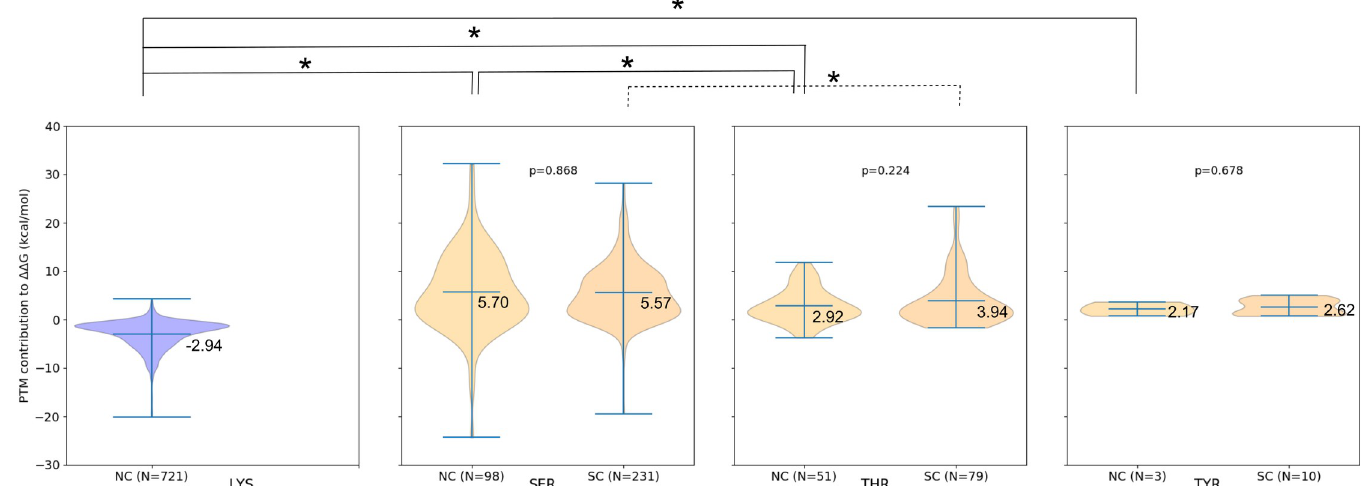
Fig 2. Comparison of local binding contributions between conditions and PTM types for the interface-located PTMs. ΔΔ G bind,contribution values in two conditions for each type of PTM (acetylation in blue, phosphorylation in orange), where NC stands for “normal conditions” and SC for “stress conditions”. Acetylation more frequently contributes to binding in a stabilizing way, as reflected in the majority of the violin plot being below zero, while the opposite is true for phosphorylation. No significant differences were found between ΔΔ G bind,contribution for PTMs of the same type between normal and stress conditions ( p -values indicated on the plots). Comparison of ΔΔ G bind,contribution values between different types of PTMs within a given condition shows several statistically significant differences, connected by the lines (full line for NC and dashed for SC) and marked with stars above the plots. The corresponding p -values are: p (Lys-Ser, NC) = 1.3e-76, p (Lys-Thr, NC) = 7 . 7 e-39, p (Lys-Tyr, NC) = 2.3e-03, p (Ser-Thr, NC) = 2.0e-02, and p (Ser-Thr, SC) = 2.9e-02. Cohen’s d- values indicate that the effect sizes vary from small ( d (Ser-Thr, SC) = 0.29, d (Ser-Thr, NC) = 0.45) to large ( d (Lys-Ser, NC) = 1.43, d (Lys-Thr, NC) = 1.82, d (Lys-Tyr, NC) = 2.23).